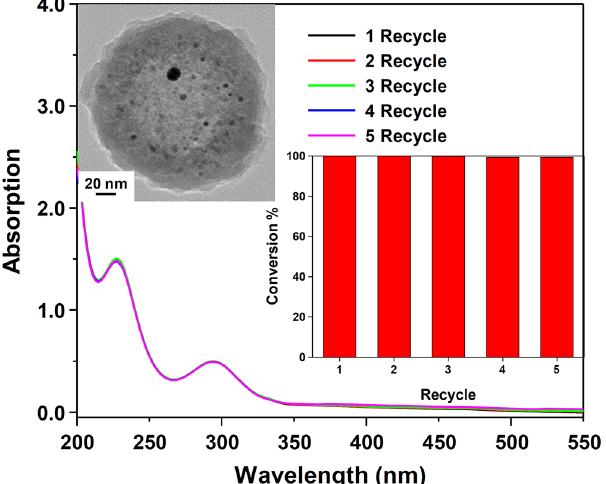
Figure 7. UV-vis spectra of 4-nitrophenol 10 min after the addition of recycled Au@hmC-FeCo/GCs for the five consecutive reduction reactions. Inset: a TEM image of the Au@hmC-FeCo/GC obtained after the fifth recycle experiment and a graph of the conversion of 4-nitrophenol in 10 min versus the number of catalyst